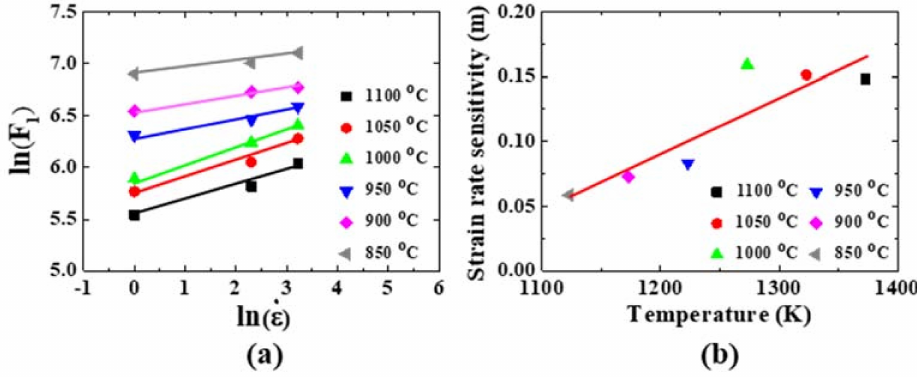
(cid:1) (cid:0) . ε and